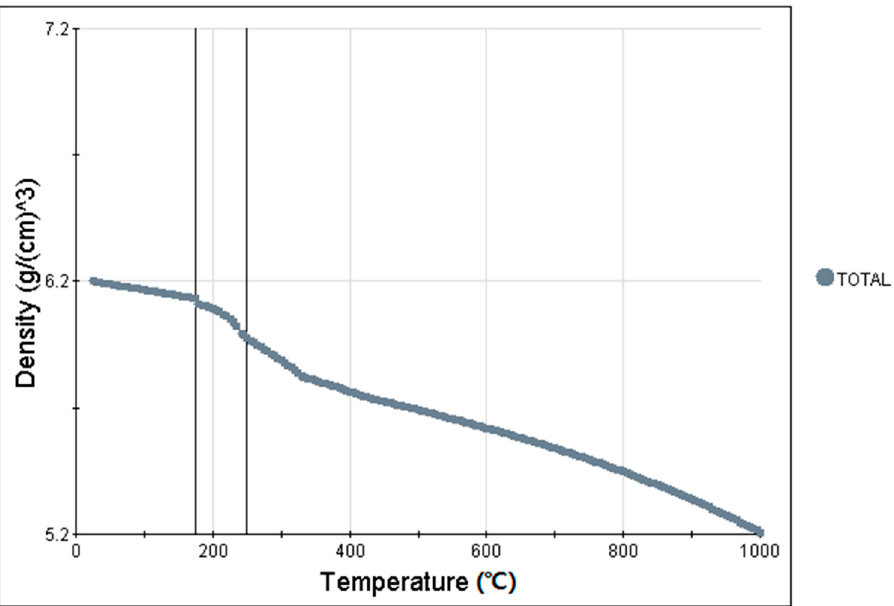
Figure 1. Results of analysis of solidification phases and properties: density (g/cm − 3 )—temperature (°C).